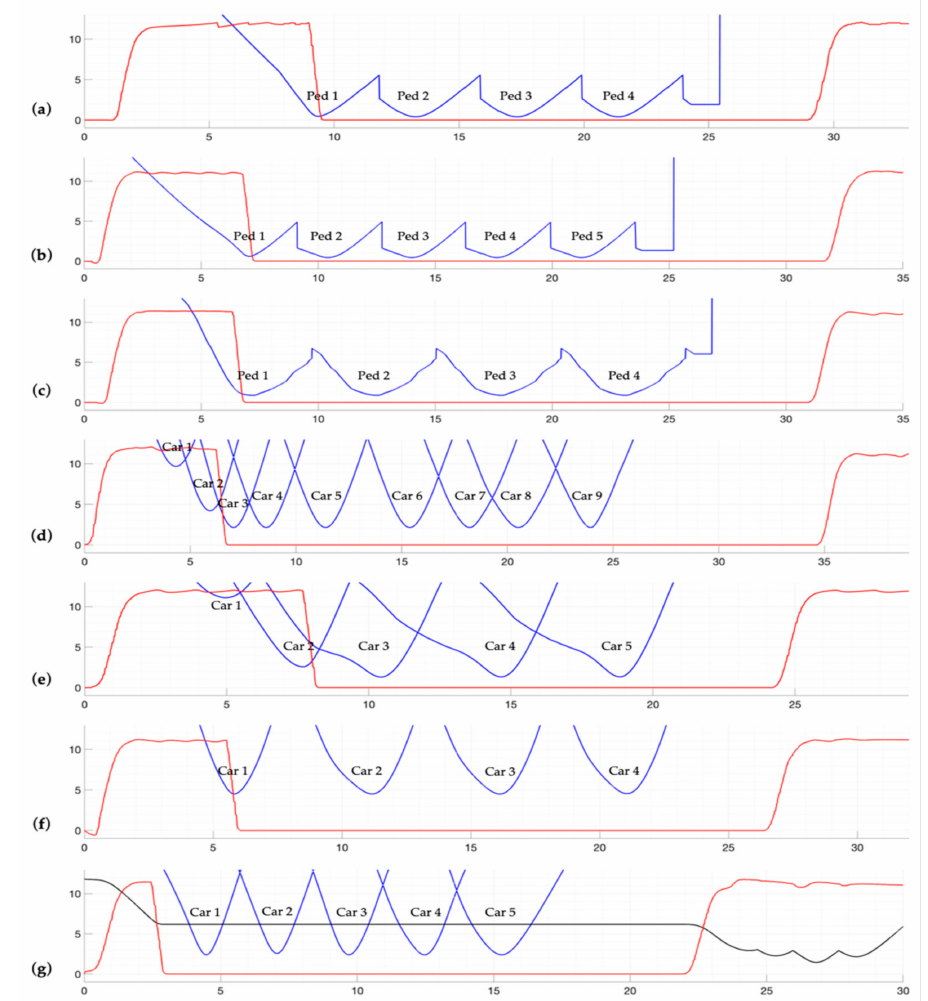
Figure 14. The performance result for each hazardous scenario: ( a – c ) The results are regarded as moving pedestrians; ( d – g ) The results are regarded as moving vehicles. The X -axis means period of time. For the blue/black lines, the Y -axis means distance error denoted as meters between the micro-EV and obstacles. For the red lines, the Y -axis means current longitudinal speed in